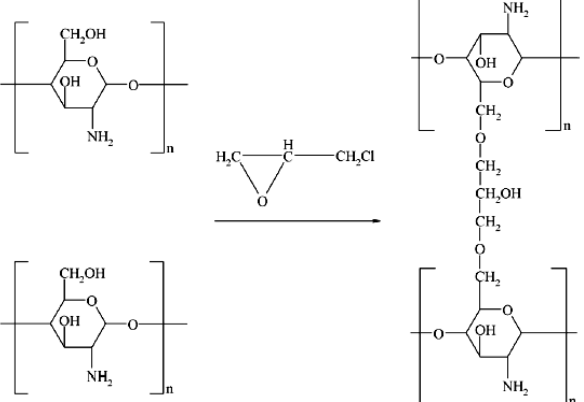
Figure 5. Schematic representation for the cross-linking reaction of chitosan with